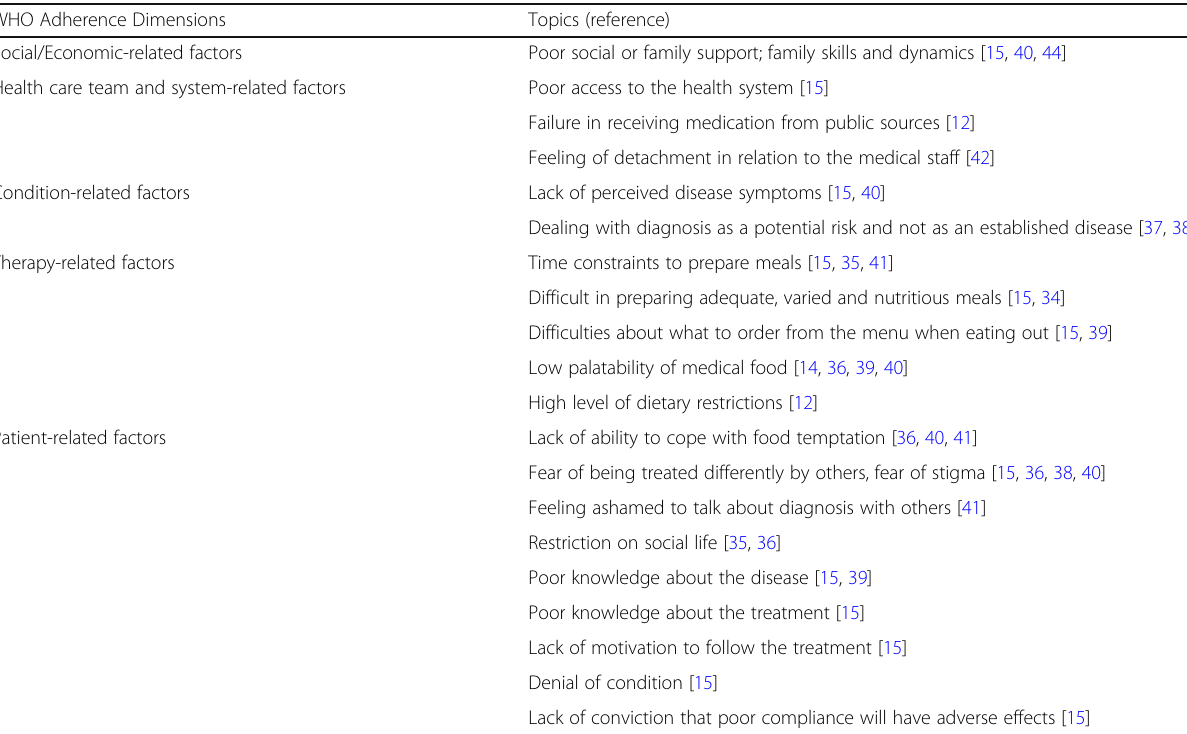
Table 2 The five dimensions of adherence and topics related to PKU treatment according to literature WHO Adherence